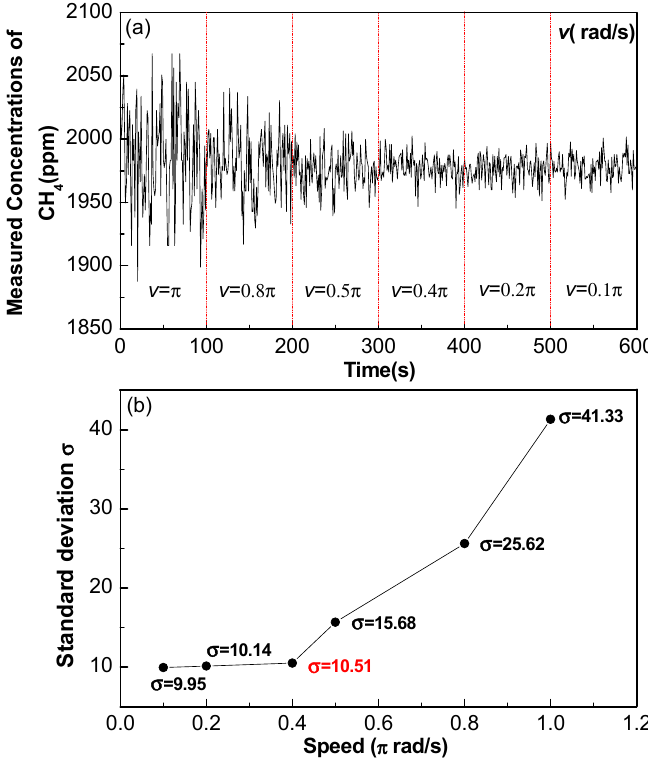
Figure 7. ( a ) Measured CH 4 concentration and ( b ) the standard deviation as a function of rotation speed, where, the measurements lasted for 100 s for each speed.